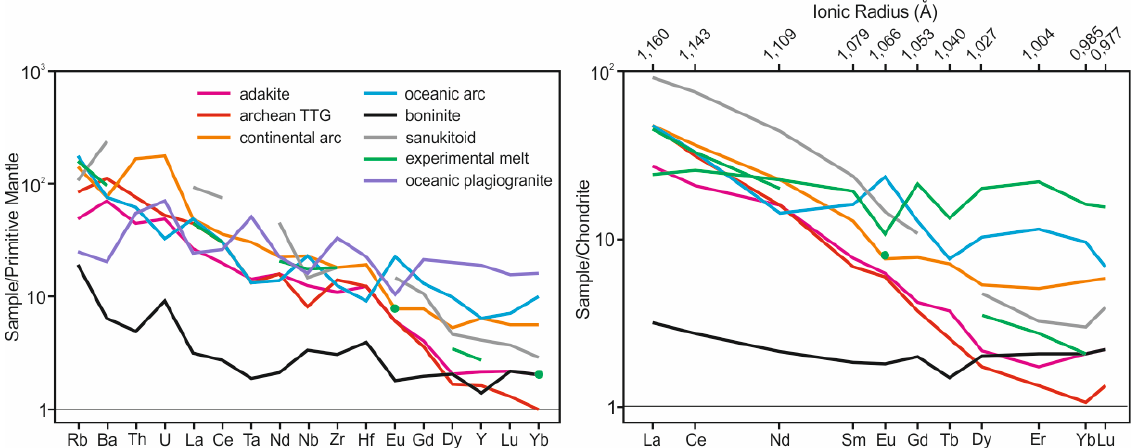
Figure 2. Geochemical characteristics of adakite compared to average Archean tonalite-trondhjemite-granodiorite (TTG) [50], andesite-dacite-rhyolite from continental and oceanic arcs [50], boninite [50], Archean sanukitoid [80], oceanic plagiogranite [50] and experimental melt from metabasaltic source [80]. Primitive mantle and chondrite normalizing values are from [104].